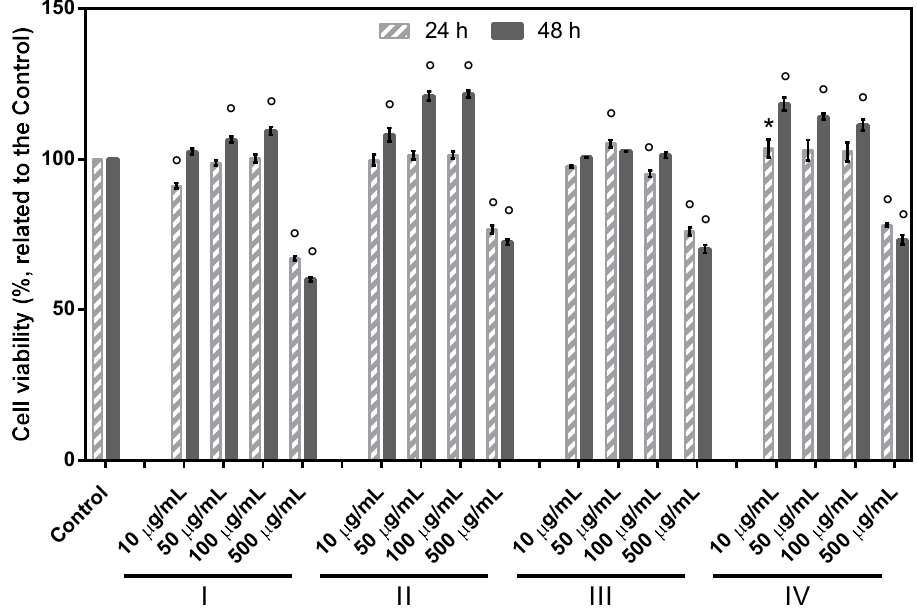
Figure 4. Viability of fibroblasts (NCTC clone L929, ATCC) cultivated in the presence of different concentrations of formulations I, II, III, IV, evaluated by MTT test at 24 and 48 h. Data represent the mean ± SD ( n = 3). (* p < 0.05; ◦ p < 0.0001 compared to untreated control).